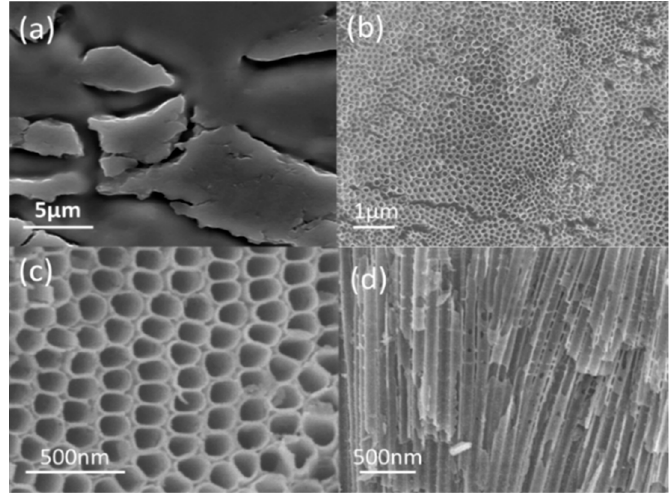
ff erent magnifications, 2 nanotube arrays under di